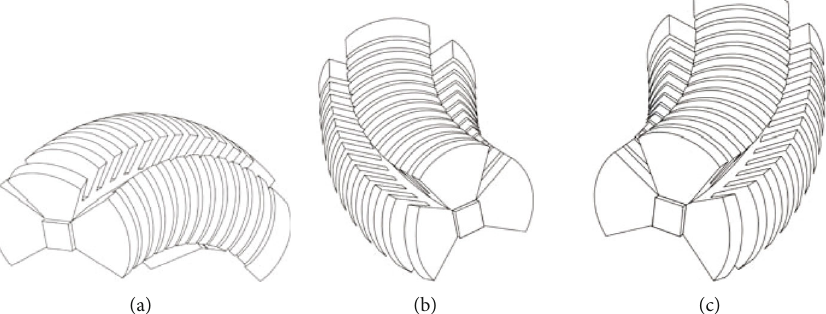
Figure 2: Periodic motion process diagram of pneumatic soft-bodied bionic actuator. (a) Middle part bending, (b) Left side bending. (c) Right side bending.